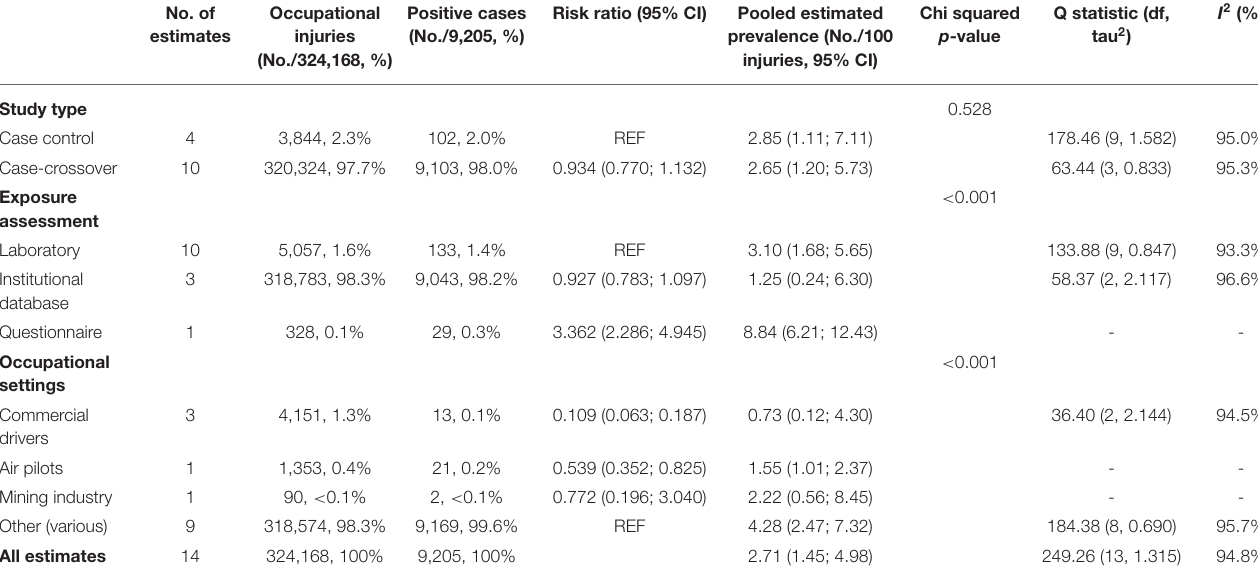
TABLE 3 | Meta-analyses of selected studies by estimates types, exposure assessment, and occupational settings (95% CI = 95% Confidence